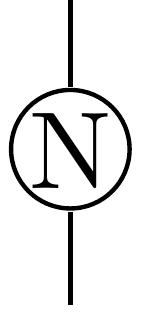
Figure 31. W-Parking, abbrev.